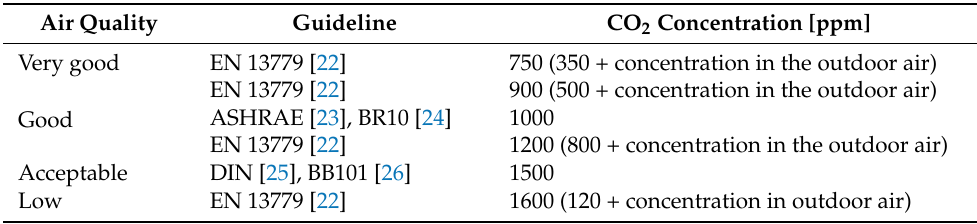
Table 1. Requirements regarding maximum CO 2 concentrations in different